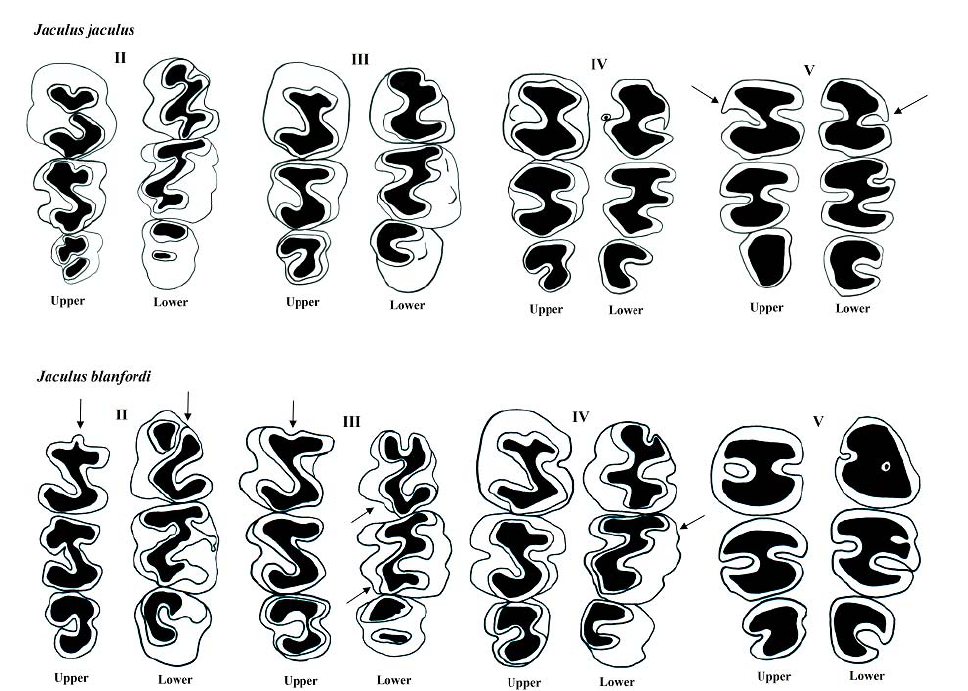
F IGURE 9. Different age sets in upper and lower molars in Jaculus . Above: J.jaculus and Bottom: J.blanfordi . The first age set not